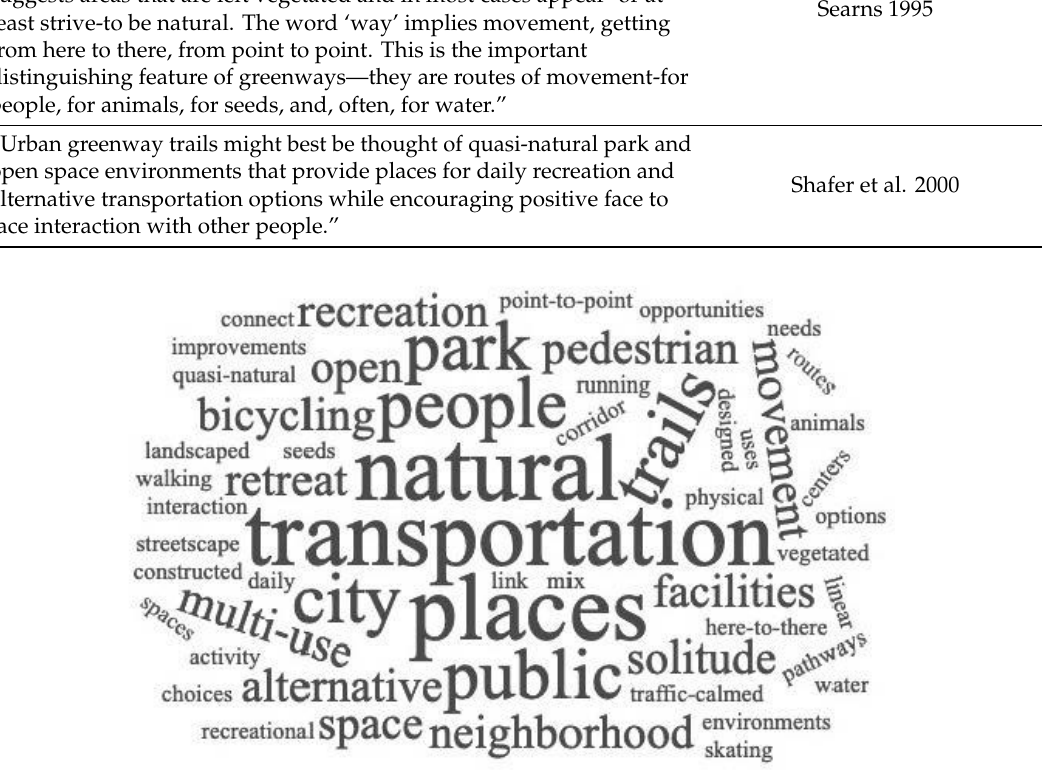
Figure 5. Word cloud of common terms in urban greenway(s) definitions. Developed at https://www.wordclouds.com/.